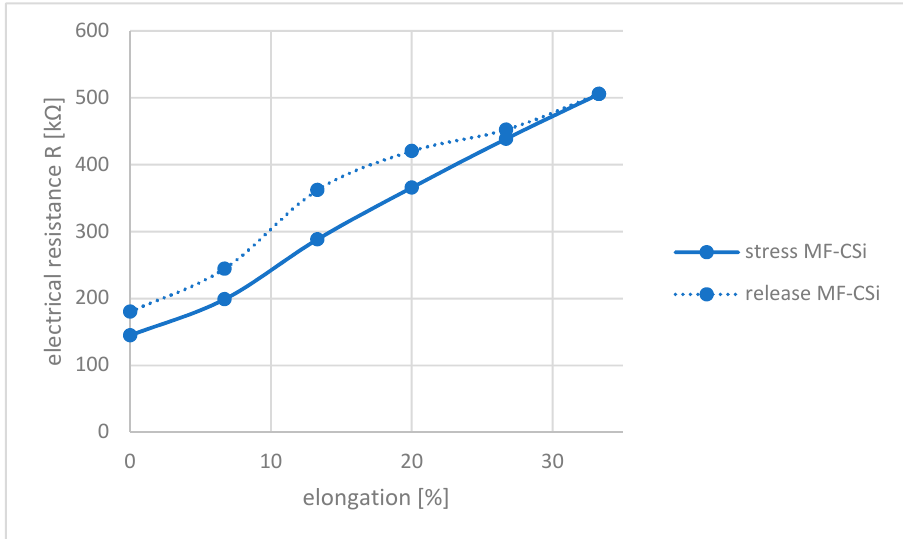
Figure 6. Electrical Resistance R as function of elongation for carbon silicone coated monofilament (MF-CSi) (length in relaxed state 150 mm).